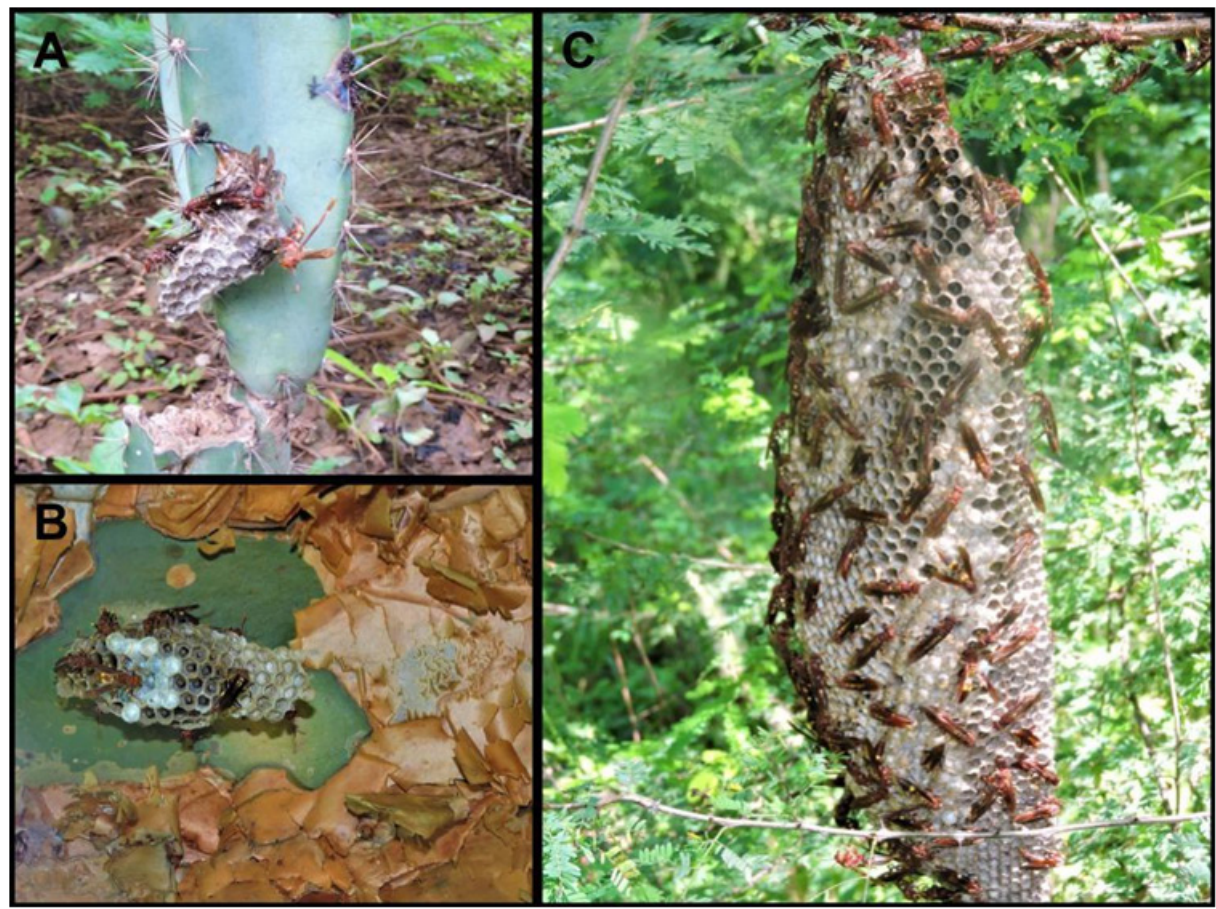
Fig 2. Colonies of Polistes versicolor in (A) Cereus jamacaru , (B) Commiphora leptophloeos and (C) Acacia plumosa . Therefore, due to the rhytidome projections, we interpret Table 1. Number of colonies of Polistes versicolor found in each plant species in the Dry Forest State Park. the occurrence of P. versicolor nesting on imburana due to the possibility of providing nest camouflage (Figure